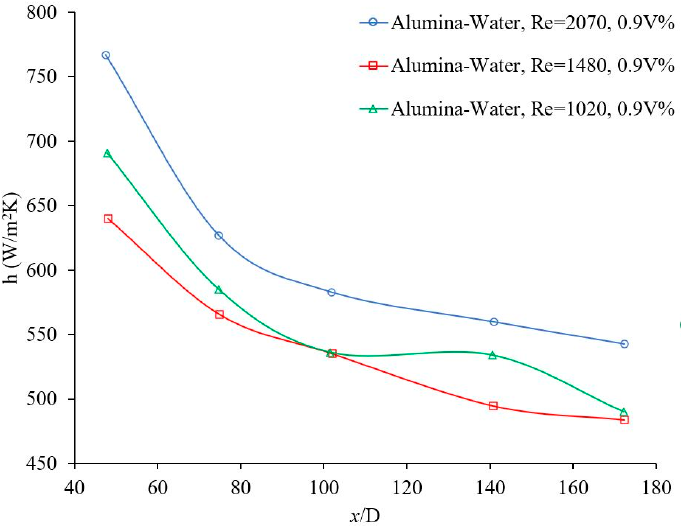
Figure 4. Effect of Reynolds number on heat transfer coefficient, Noghrehabadi and Pourrajab [15].